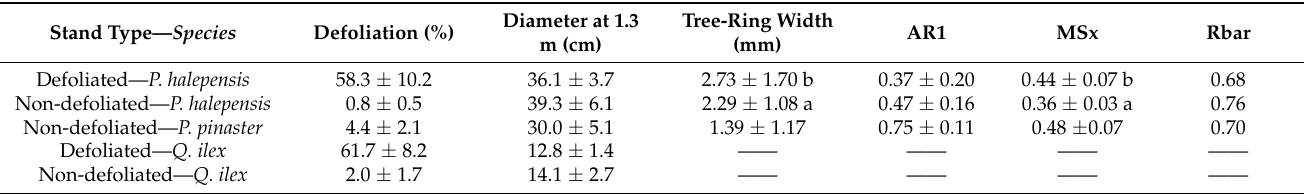
Table 1. Defoliation, diameter and tree-ring width statistics of sampled trees. Values are means ± SD. The tree-ring statistics were calculated for the period 1980–2020, prior to the cold spell. Different letters indicate significant ( p < 0.05) differences between stands of the same species according to